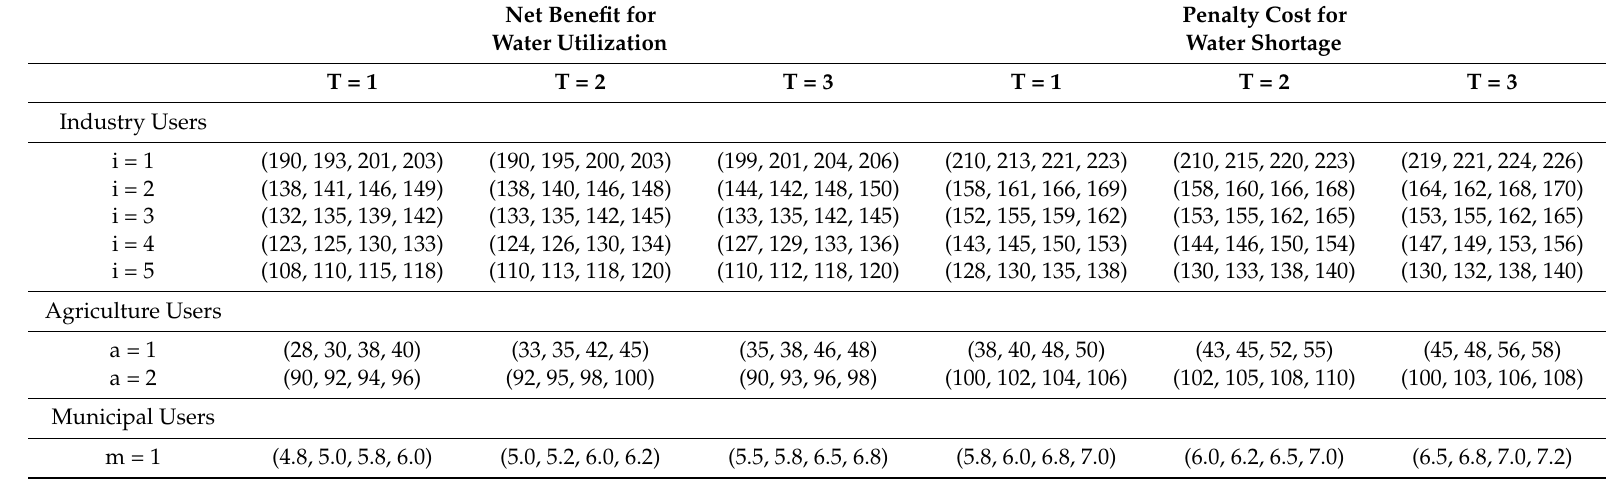
Table 3. Local economic parameters used in the water system